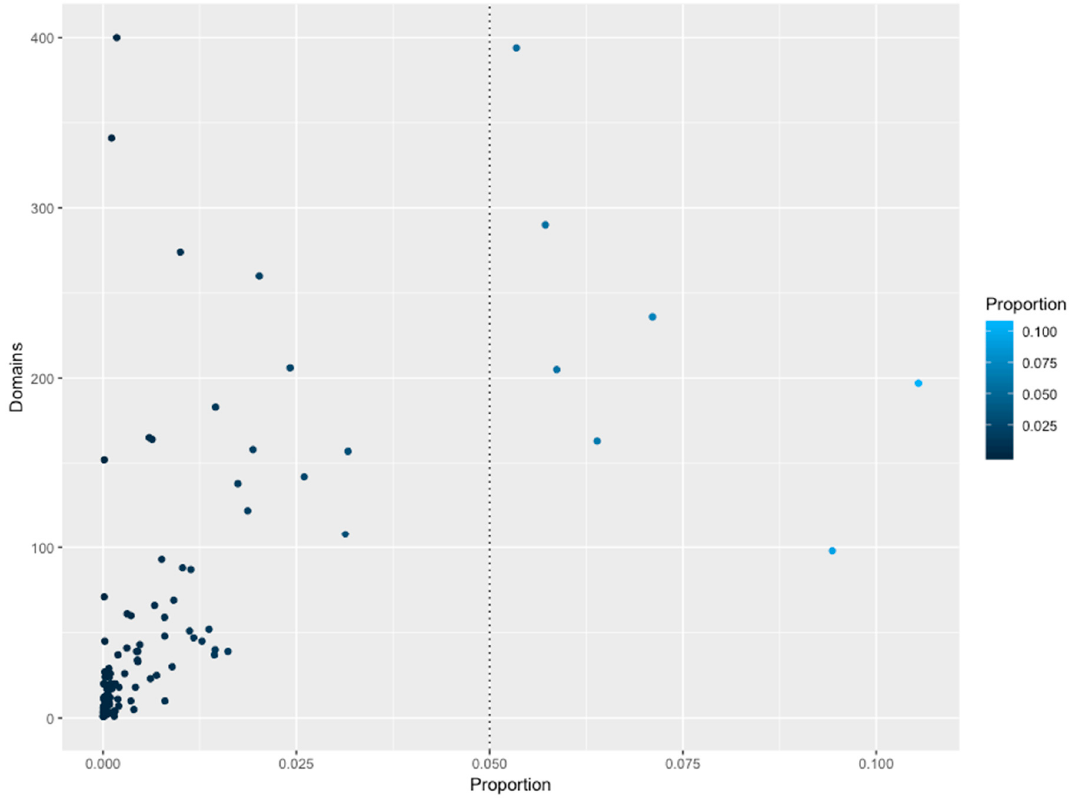
Figure 4. Number of NR domains associated with TF families. The X-axis indicates the proportion (as a percentage) of abundance of a given family versus the total of TFs. The Y-axis indicates the total number of non-redundant domains per family. The dotted line indicates the most abundant families.